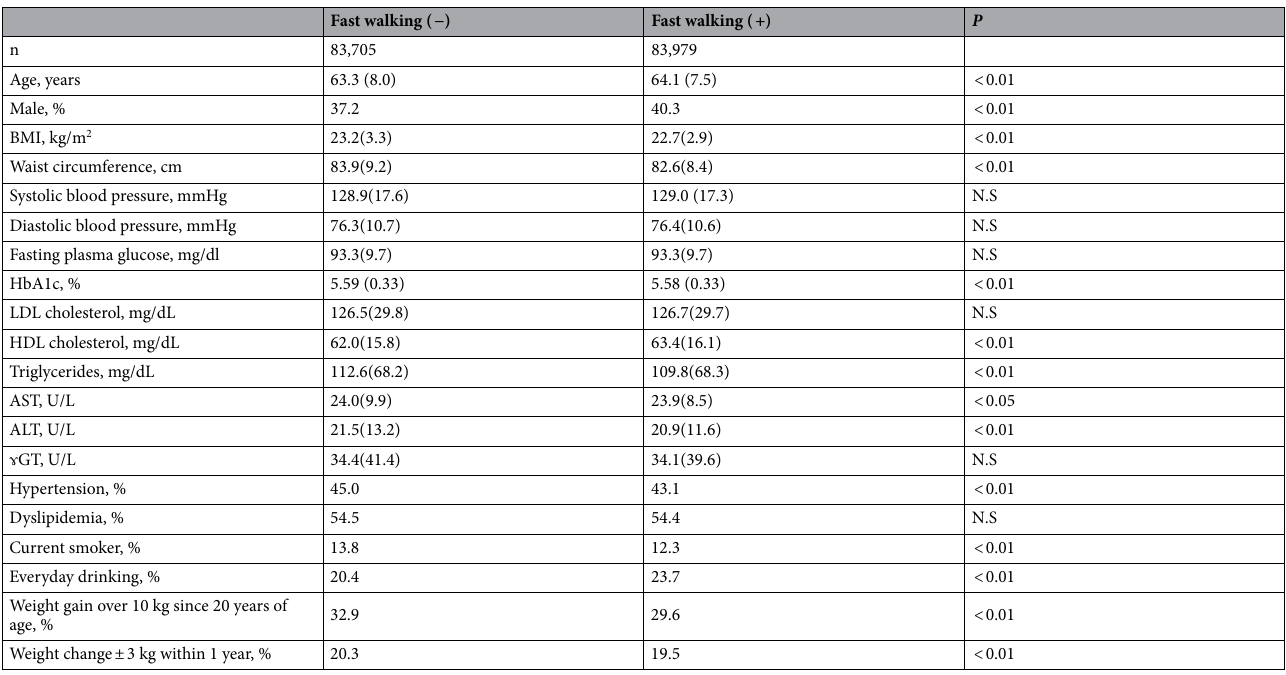
Table 3. Baseline characteristics of participants with or without fast walking. Values are Mean (SD) or %. P provability by two-tailed unpaired t test or χ 2 test. BMI body mass index, AST aspartate aminotransferase, ALT alanine aminotransferase, γGT γ-glutamyl transpeptidase, N.S. not